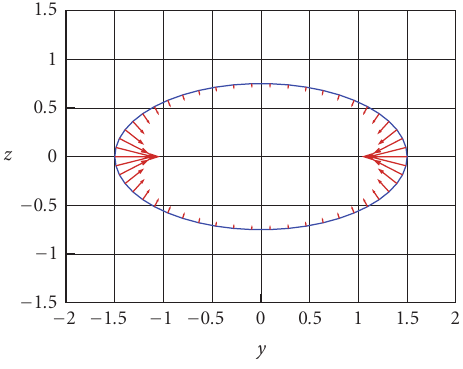
Figure 6.6. Normal stress ( T nn n y + T nn n z ) / 2 . 5dyn/cm 2 for an ellipse y 2 /b 2 + z 2 /c 2 = 1 at x = 0 . 0 cm in the ( y , z )-plane. Perpendicular view of the cross section (e) in Figure 6.1. There is still compression right in the middle of the ellipsoid.